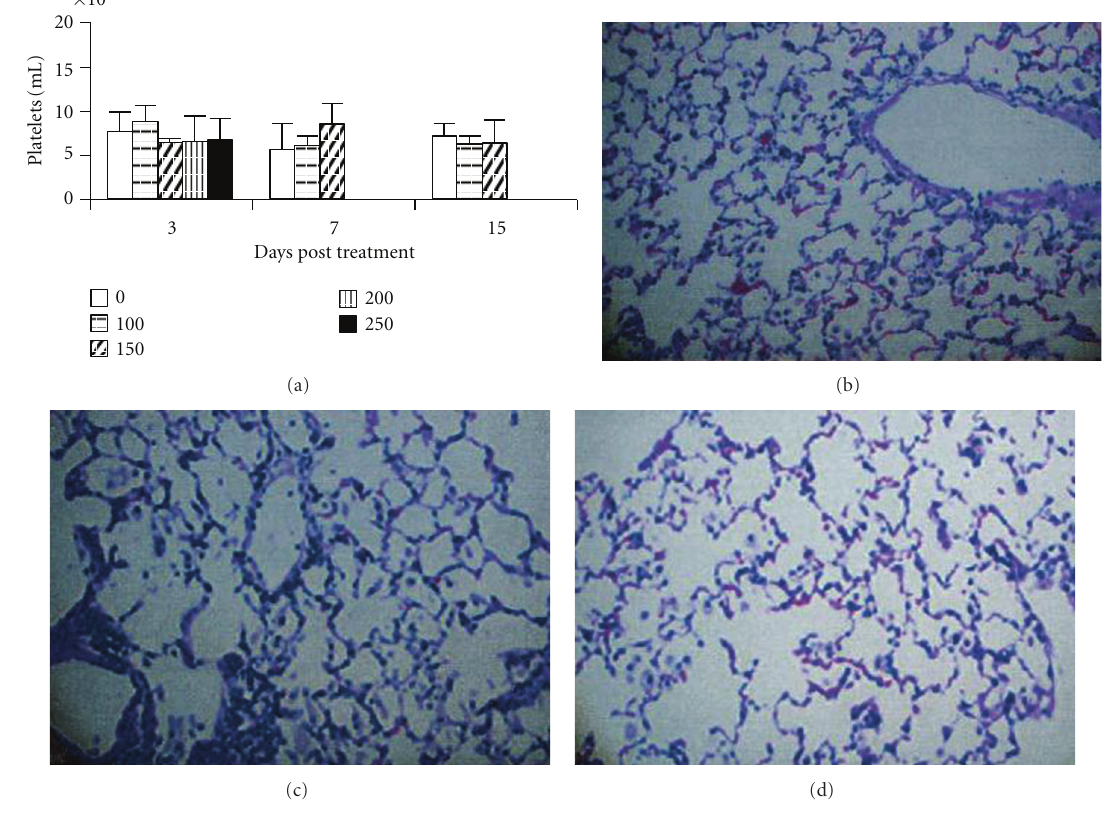
Figure 2: Toxicity of RIT in mice with CN infections. (a) Platelet counts in RIT-treated mice. CN-infected A/JCr mice received various doses of 213 Bi-18B7. A “0” indicates infected nontreated mice. Mice treated with 200 and 250 μ Ci 213 Bi-18B7 died by day 7 posttreatment; (b–d) micrographs of hematoxylin-and-eosin-stained lungs from BALB/c mice infected IT with CN and treated with radiolabeled mAbs. Mice were sacrificed 5 months after RIT: (b) infected control group (no RIT); (c) 200 μ Ci 213 Bi-18B7; (d) 200 μ Ci 188 Re-18B7; adapted from